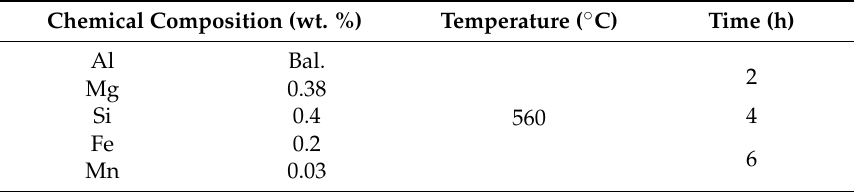
Table 1. Chemical composition and homogenization conditions for the 6060